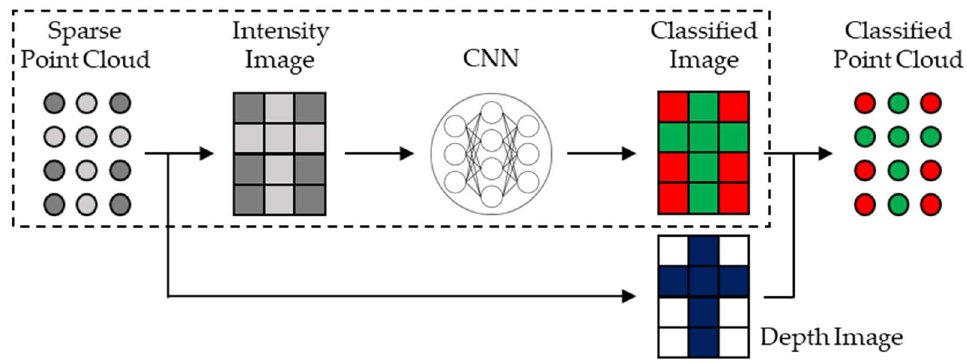
Figure 1. Road marking extraction procedure.